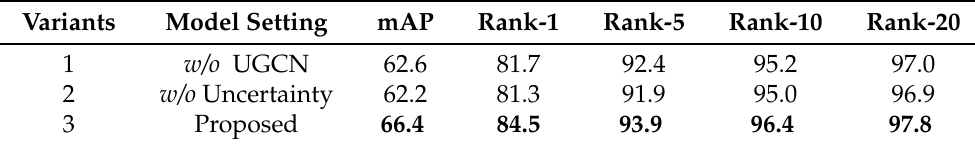
Table 1. Ablation study on the Market-1501